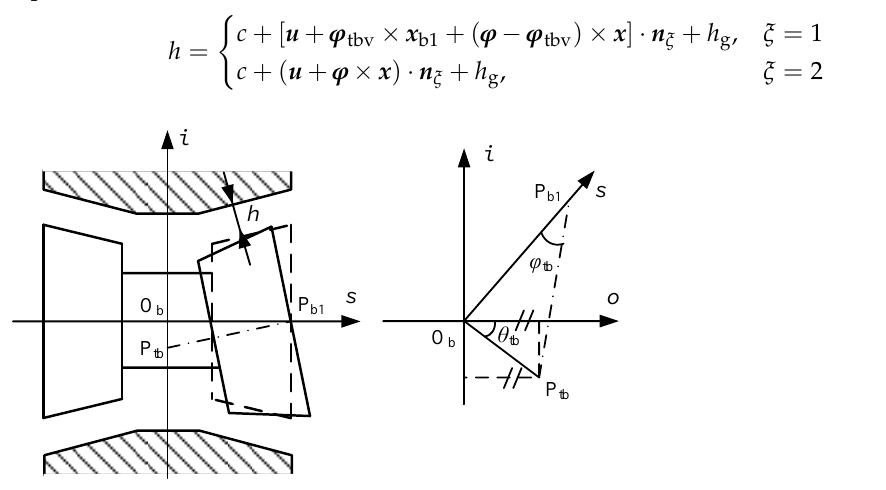
Figure 6. Schematic of angular deviation of the axis.